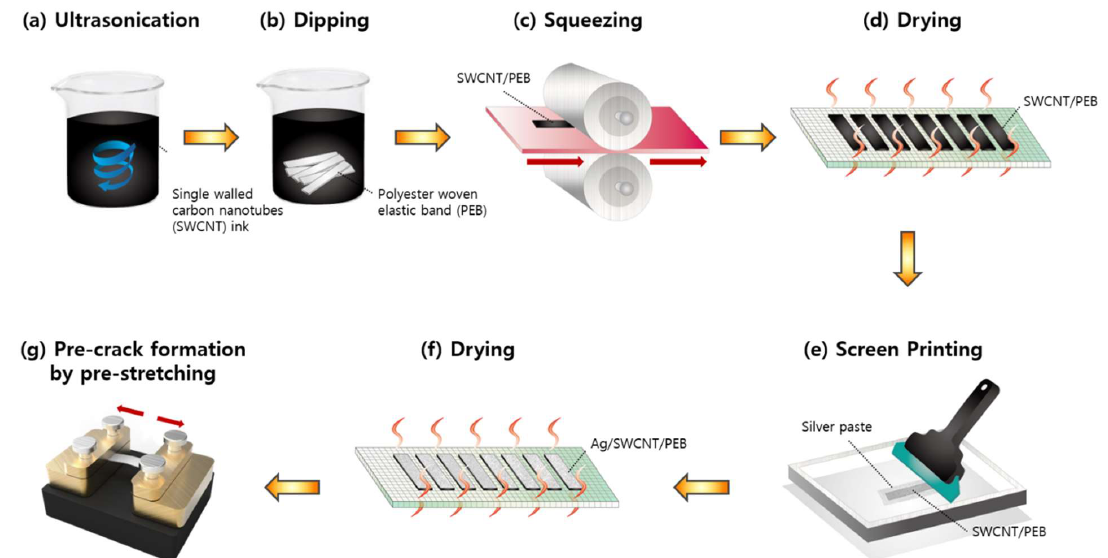
Figure 1. The manufacturing process for strain sensors based on polyester woven elastic band (PEB): ( a ) ultrasonication of single-walled carbon nanotube (SWCNT) ink; ( b ) dipping PEB into SWCNT ink; ( c ) squeezing SWCNT/PEB; ( d ) drying SWCNT/PEB; ( e ) screen printing for silver-paste coating; ( f ) drying Ag/SWCNT/PEB; ( g ) pre-crack formation by pre- stretching to make pre-cracked Ag/SWCNT/PEB.